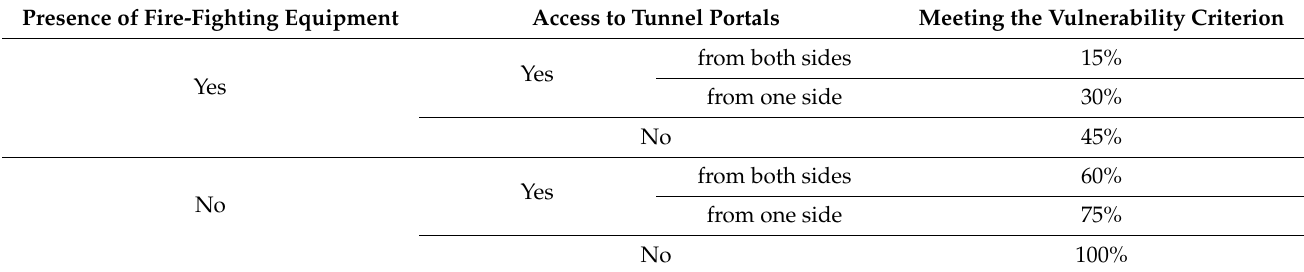
Table 14. Access to Tunnel and Fire-Fighting